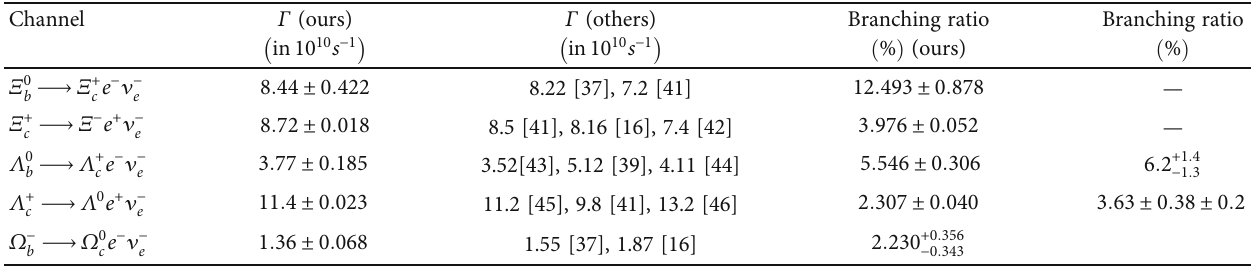
= 1 : 471 ± 0 : 009 , τ Λ 0 b